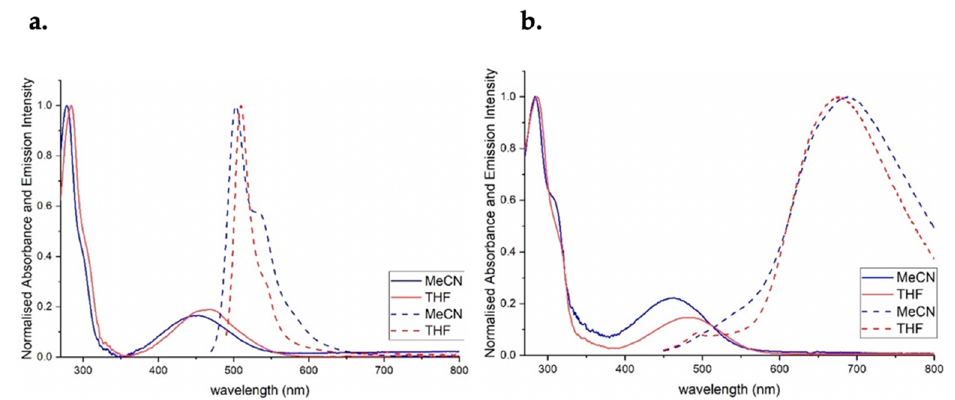
Table 1. Photophysical data for the selected BODIPY analogues.